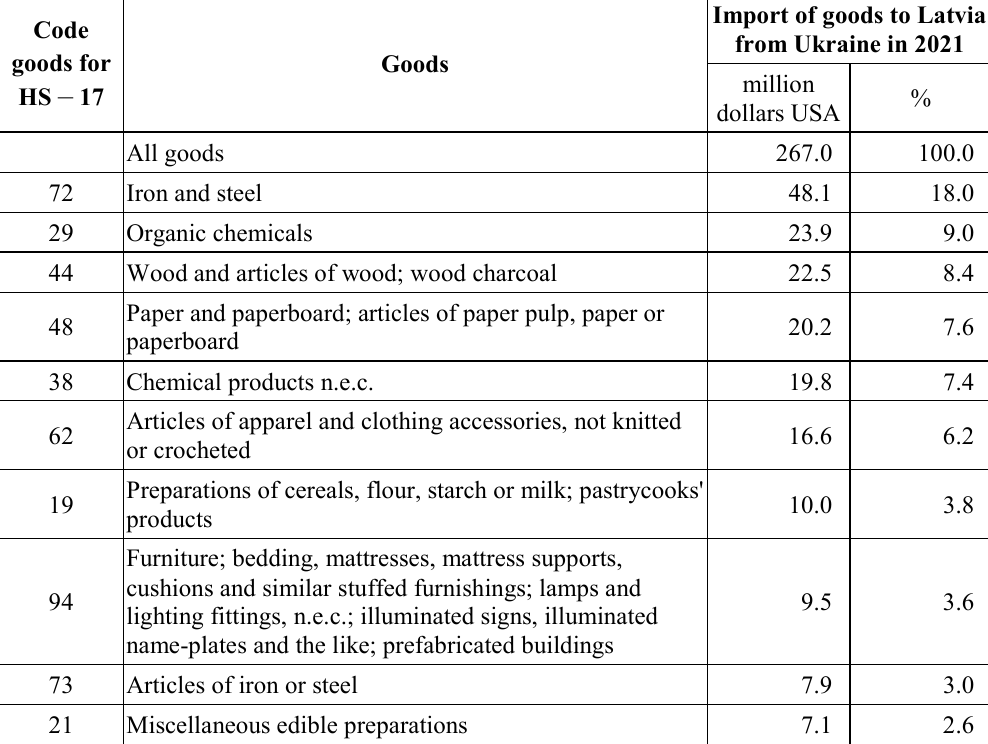
Table 4. The Main Goods Imported to Latvia from Ukraine in 2021 (calculated and summarised by the authors according to the UN Comtrade